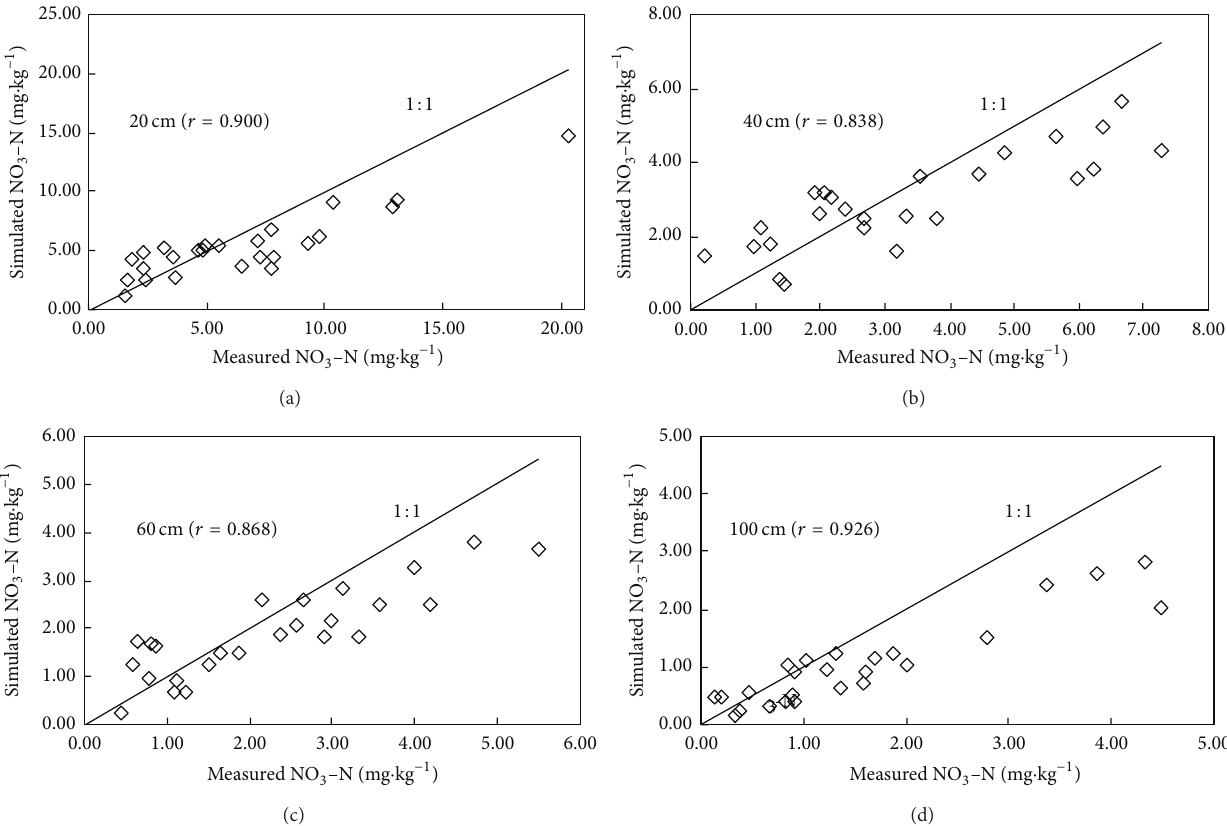
Figure 4: Comparison between simulated values and measured values of NO 3 -N with different soil layer in intensive vegetable base.